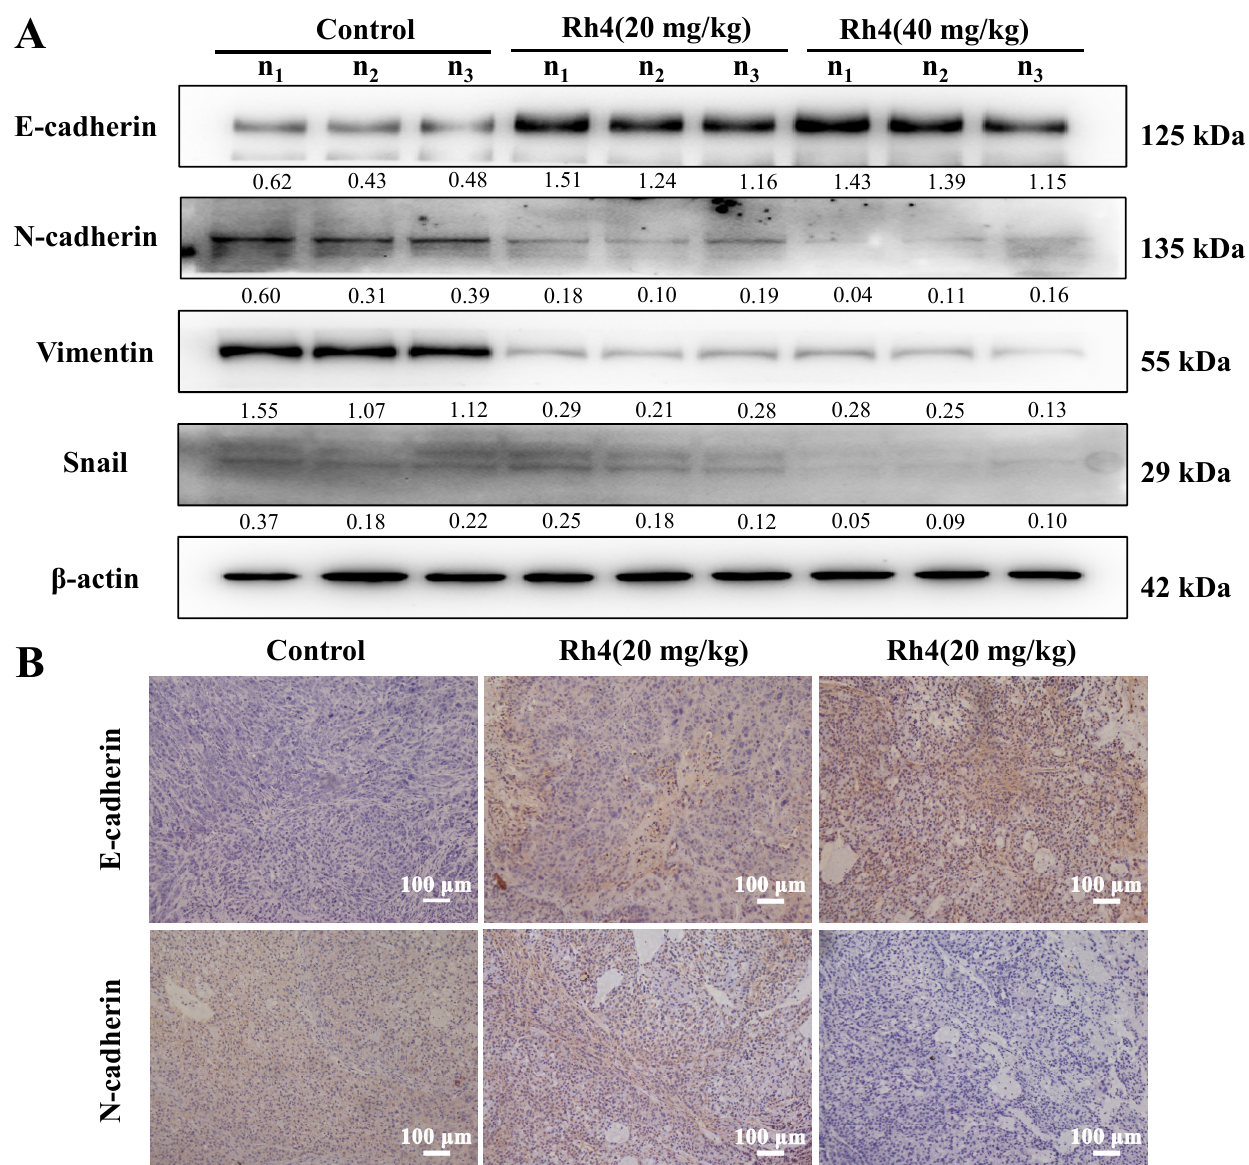
Figure 6. Ginsenoside Rh4 refrained the EMT procedure of LAC in vivo. ( A ) Western bolt analysis. Rh4 promoted the expression of E-cadherin, while inhibiting the expression of N-cadherin, vimentin and snail in tumor tissues via Western blot analysis. ( B ) Immunohistochemistry was carried out to evaluated the variations of E-cadherin and N-cadherin. β -actin was used as an endogenous reference. n1, n2 and n3 represented three different nude mice. Scale bars = 100 µ m. Data are presented from three independent